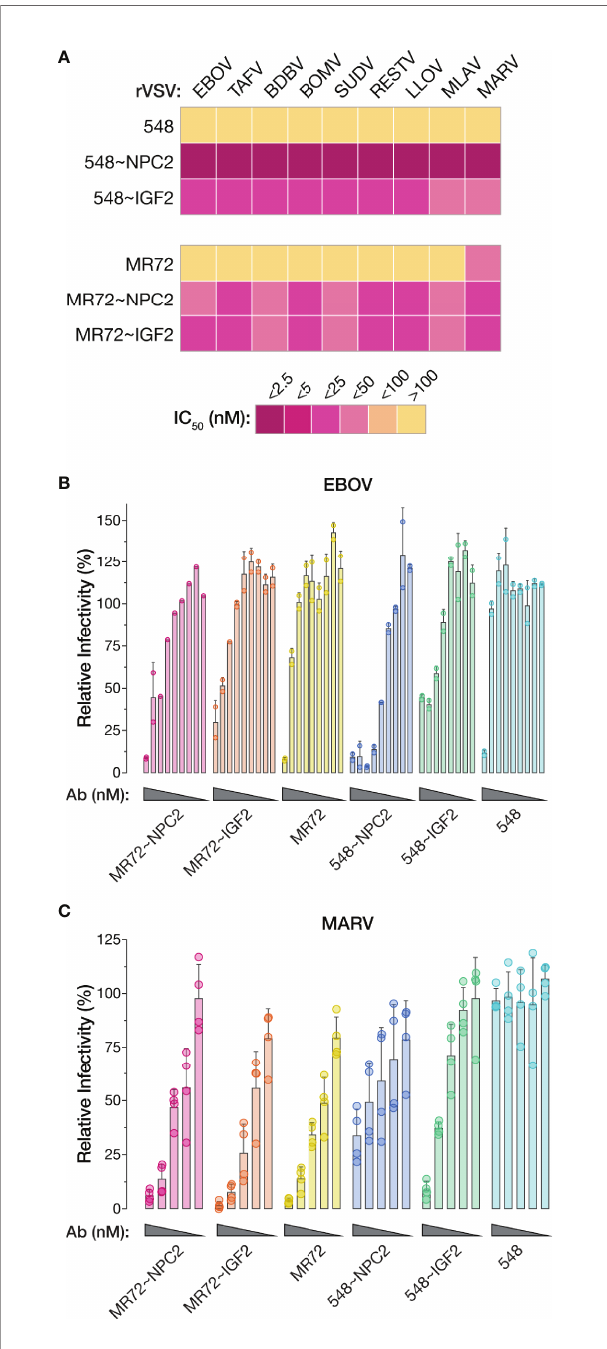
FIGURE 8 | NPC2- and IGF2-tagged bsAbs afford pan- fi lovirus entry inhibition. (A) Heat map showing neutralizing IC 50 values for parental mAbs and NPC2- and IGF2-tagged bsAbs against all rVSVs bearing fi lovirus glycoproteins. IC 50 values were calculated from neutralization curves from 4 – 6 replicates from 2 – 3 independent experiments. For curves that did not cross the 50% threshold, IC 50 values were considered >100 nM. EBOV, Ebola virus; TAFV, Tai Forest virus; BDBV, Bundibugyo virus; BOMV, Bombali virus; SUDV, Sudan virus; RESTV, Reston virus; LLOV, Lloviu virus; MLAV, Mengla virus; MARV, Marburg virus. (B, C) Neutralization of authentic (B) EBOV and (C) MARV by parental mAbs and NPC2- and IGF2-tagged bsAbs. Means ± SD are shown for 2 – 4 replicates from 1 – 2 independent